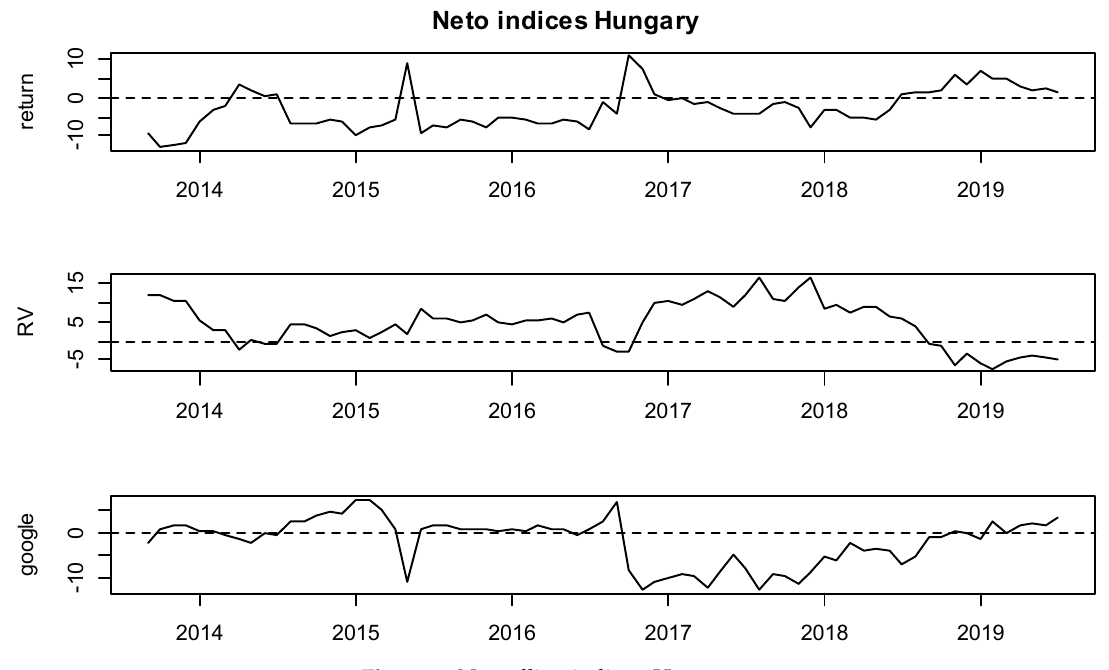
Figure 3. Net rolling indices, Hungary.